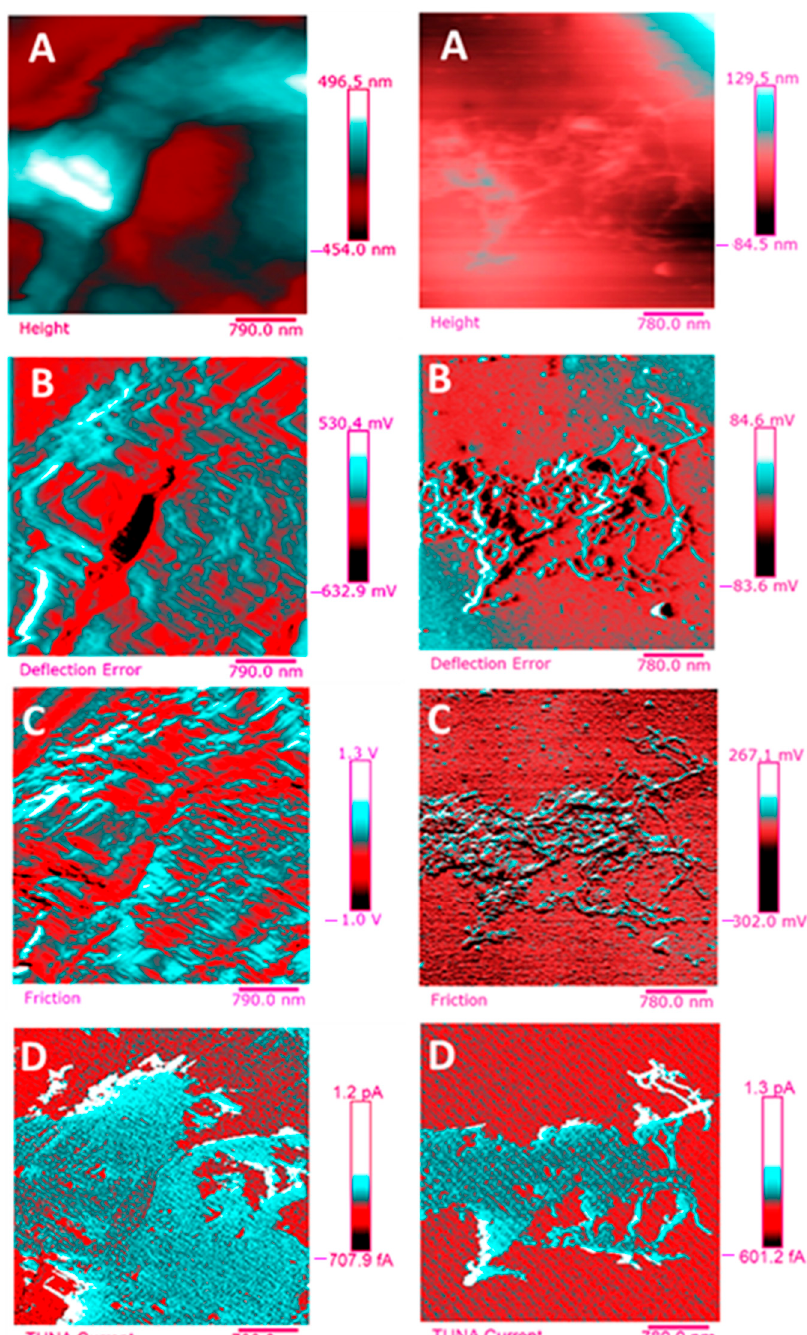
Figure 8. TUNA pictures (2D modality): ( A ) Height; ( B ) Deflection Error; ( C ) Friction; ( D ) TUNA Current of TCTBD+2%MWCNT–b (on the left) and TCTBD+2%MWCNT–t (on the right).